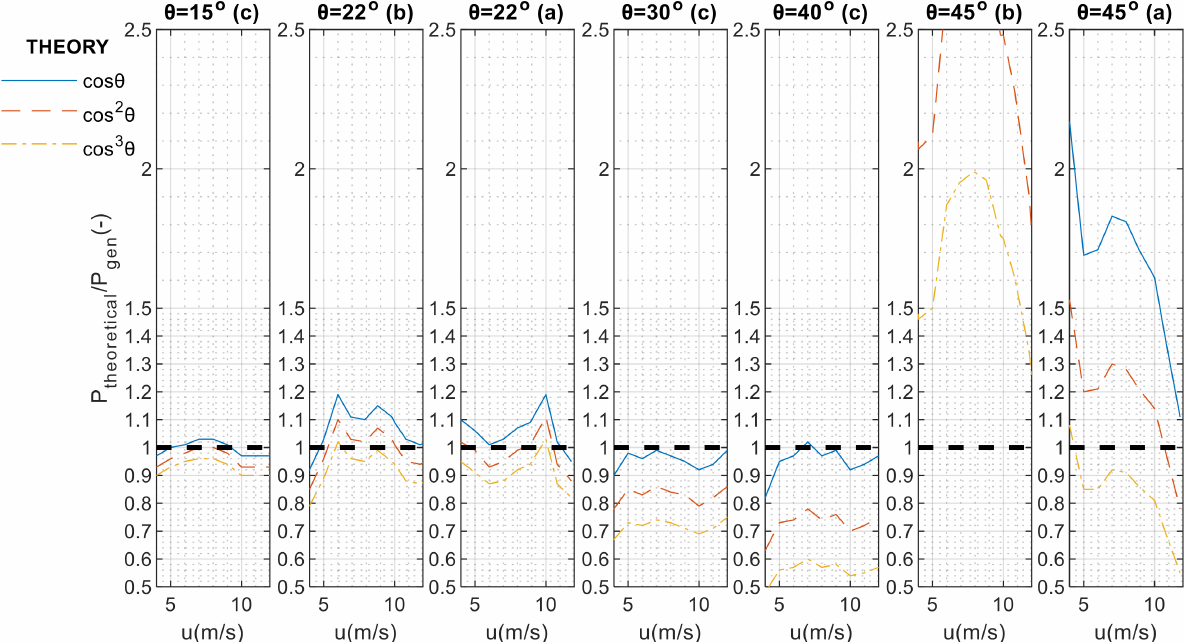
Figure 9. Ratio of theoretical power estimation from 3 different yaw misalignment theories at different skew angles θ ◦ (15 ◦ , 22 ◦ , 30 ◦ , 40 ◦ , 45 ◦ ) with the experimentally derived generated power at these skew angles for ( a ) 5 bladed upwind, ( b ) 3 bladed downwind, and ( c ) 3 bladed downwind